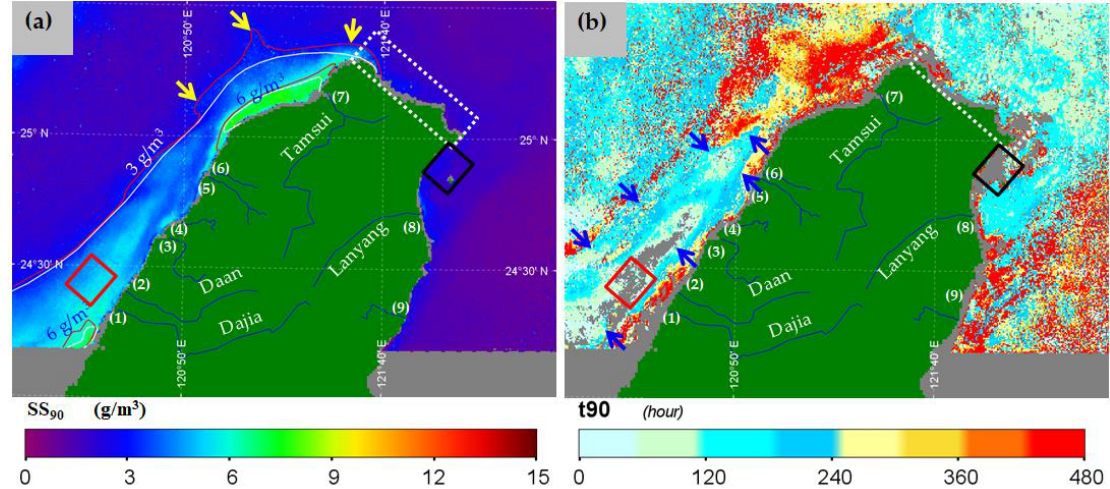
Figure 7. ( a ) SS concentration of each pixel reduced to 90% after typhoon-induced impact; ( b ) its corresponding time t 90 . White contour lines indicate SS 4 − 7 ; red contour lines indicate SS 90 .